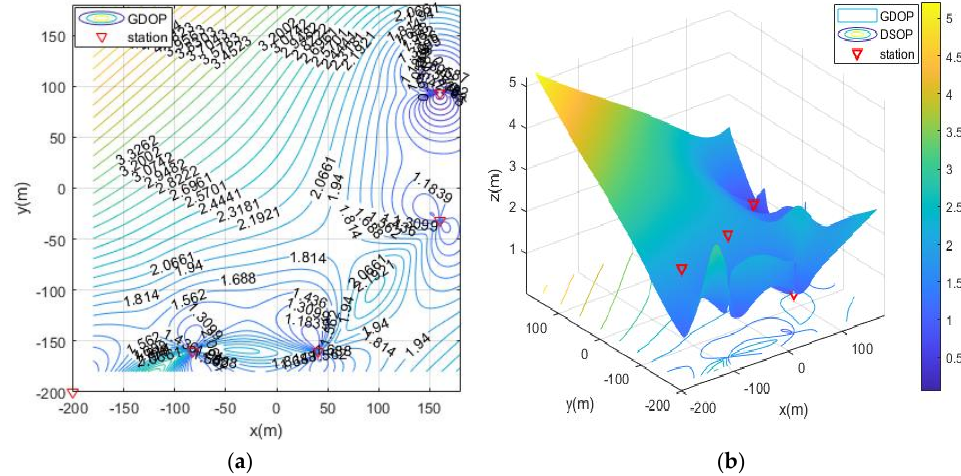
Figure 12. GDOP map of five base stations optimization results with a fixed station (–200, –200, 3) ( a ) 2D contour map of moa06; ( b ) 3D contour map of moa06.